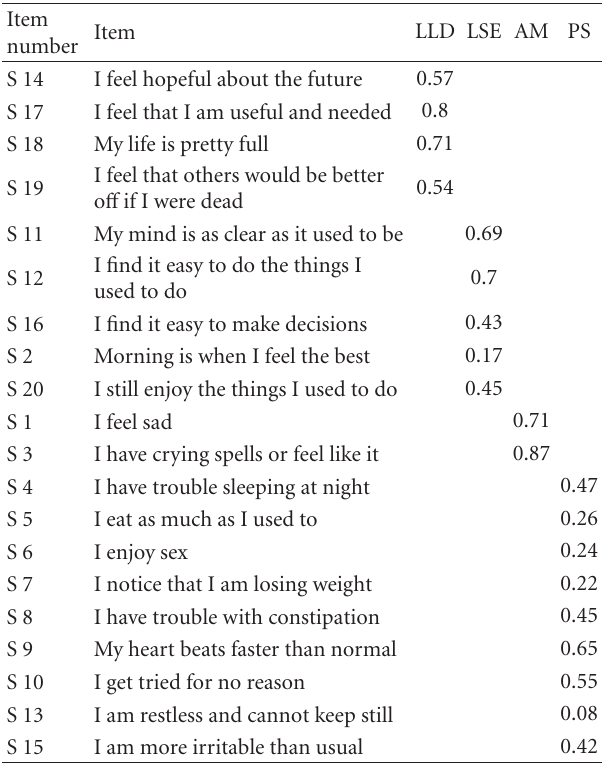
Table 1: Factor structure and factor loading of self-rating depres- sion